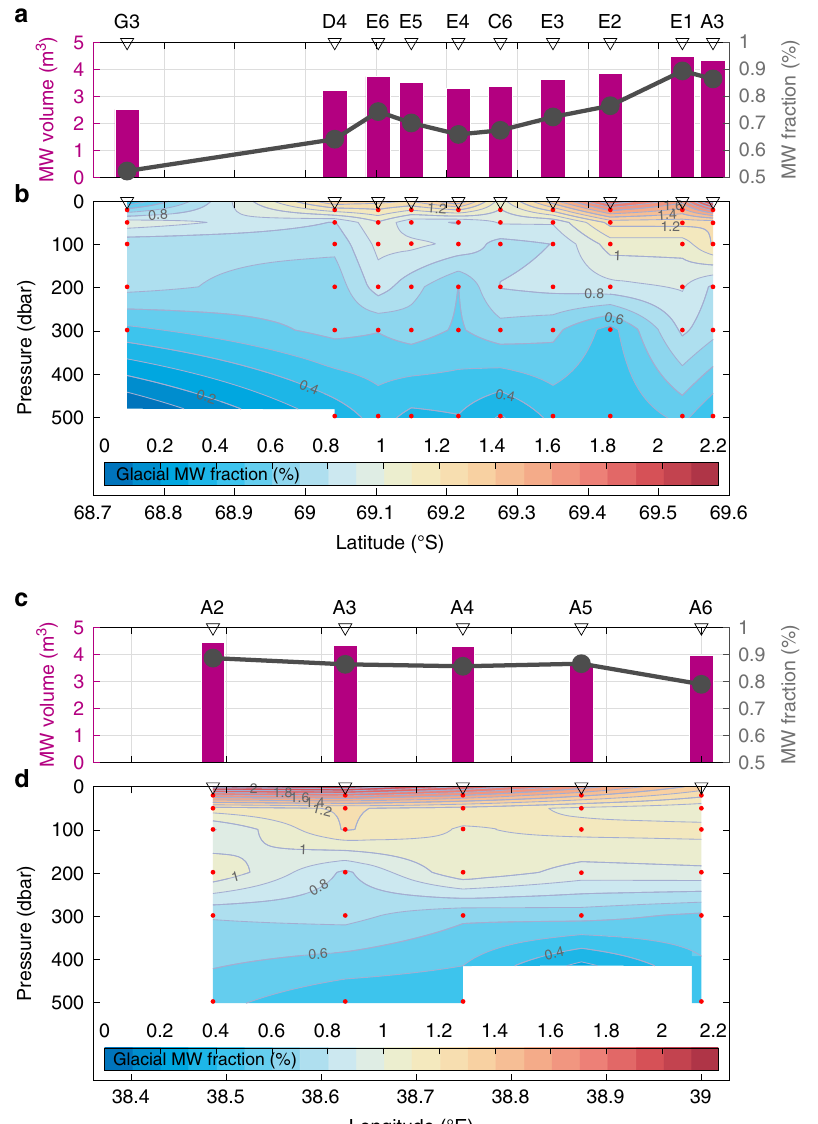
Fig. 5 Distribution of glacial meltwater. Column-integrated glacial meltwater volume per unit area (purple bar) and mean glacial meltwater fraction (%, line with dot) above 500 dbar ( a ) along- and ( c ) across-trough stations. Vertical sections of glacial meltwater fraction (%) ( b ) along- and ( d ) across- trough stations. Red dots indicate locations for water samples. The glacial meltwater fractions are linearly interpolated between water sample points and extrapolated from 20 dbar to sea surface. For Sta.G3, the extrapolation is conducted also from the deepest sampling layer to